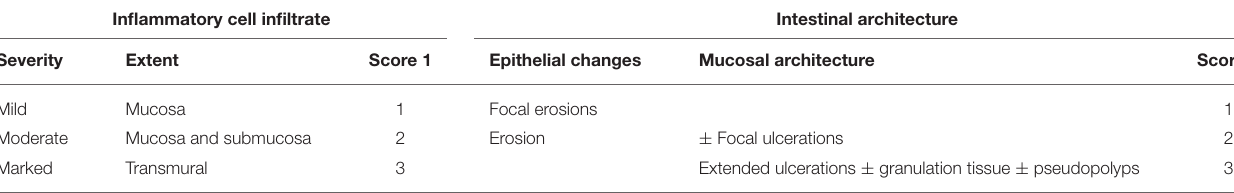
TABLE 1 | Histological scoring system for the experimental colitis animal models.